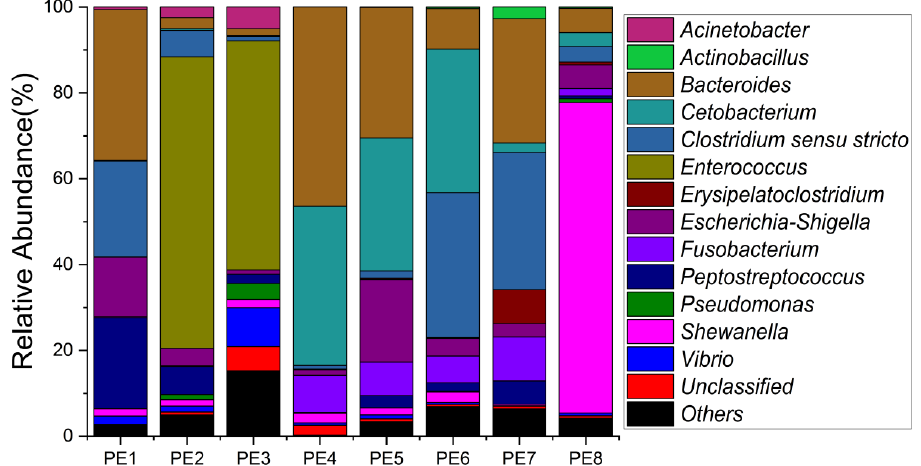
Figure 4. Gut microbial community members of eight stranded melon-headed whales (PE1-8) at the genus level.